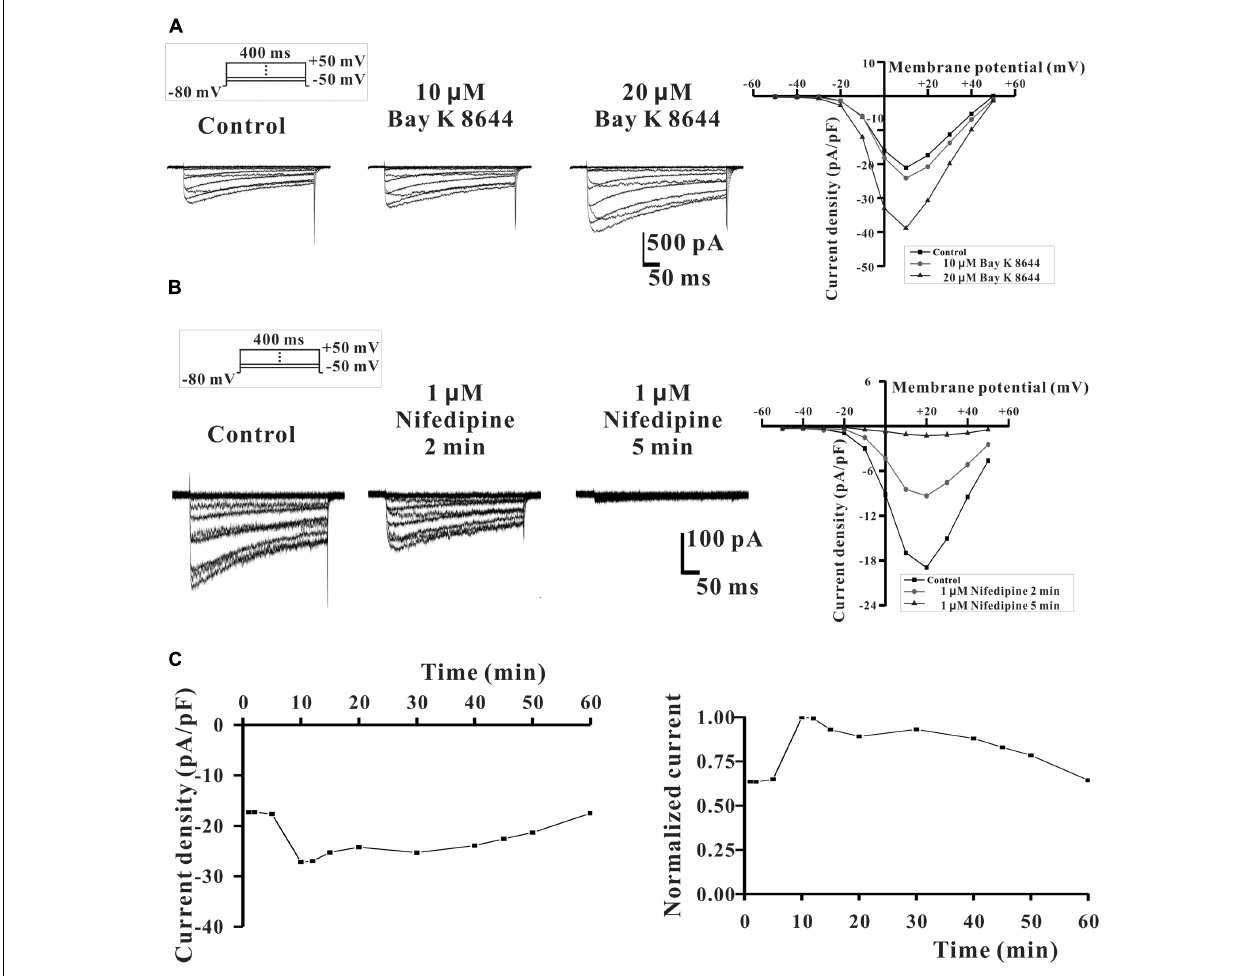
FIGURE 5 | The expression of L-type Ca 2 + channel in L Ca channel-transfected HEK293 cells. (A) The typical recordings show that L Ca channel was activated by 10 and 20 µ M Bay K 8644 (an agonist of L Ca channel). (B) L Ca channel was inhibited by 1 µ M nifedipine (an antagonist of L Ca channel). (C) I Ca , L was relative stable and I Ca , L rundown was less than 10% within 15–40 min after the whole-cell configuration formation.